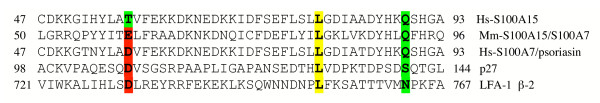
Conservation of the Jab1 binding motif in human psoriasin/S100A7 and mouse S100A7/psoriasin Human psoriasin/S100A7 contains a Jab1 binding domain identified previously in p27 and LFA-1. Mouse S100A7/psoriasin also contains the Jab1 binding motif but human S100A15 does not. Note that human S100A15 has a significant change, from a charged (D) to a neutral (T) amino acid, in the first of the essential amino acids (color coded) required for Jab1 binding. The change seen in this residue in the mouse S100A7/psoriasin protein is a conservative change and the residue (E) remains negatively charged. Amino acid color-coding: non-polar (yellow), neutral polar (green), negatively charged (red). Hs = homo sapiens, Mm = Mus musculus. Adapted from [6].